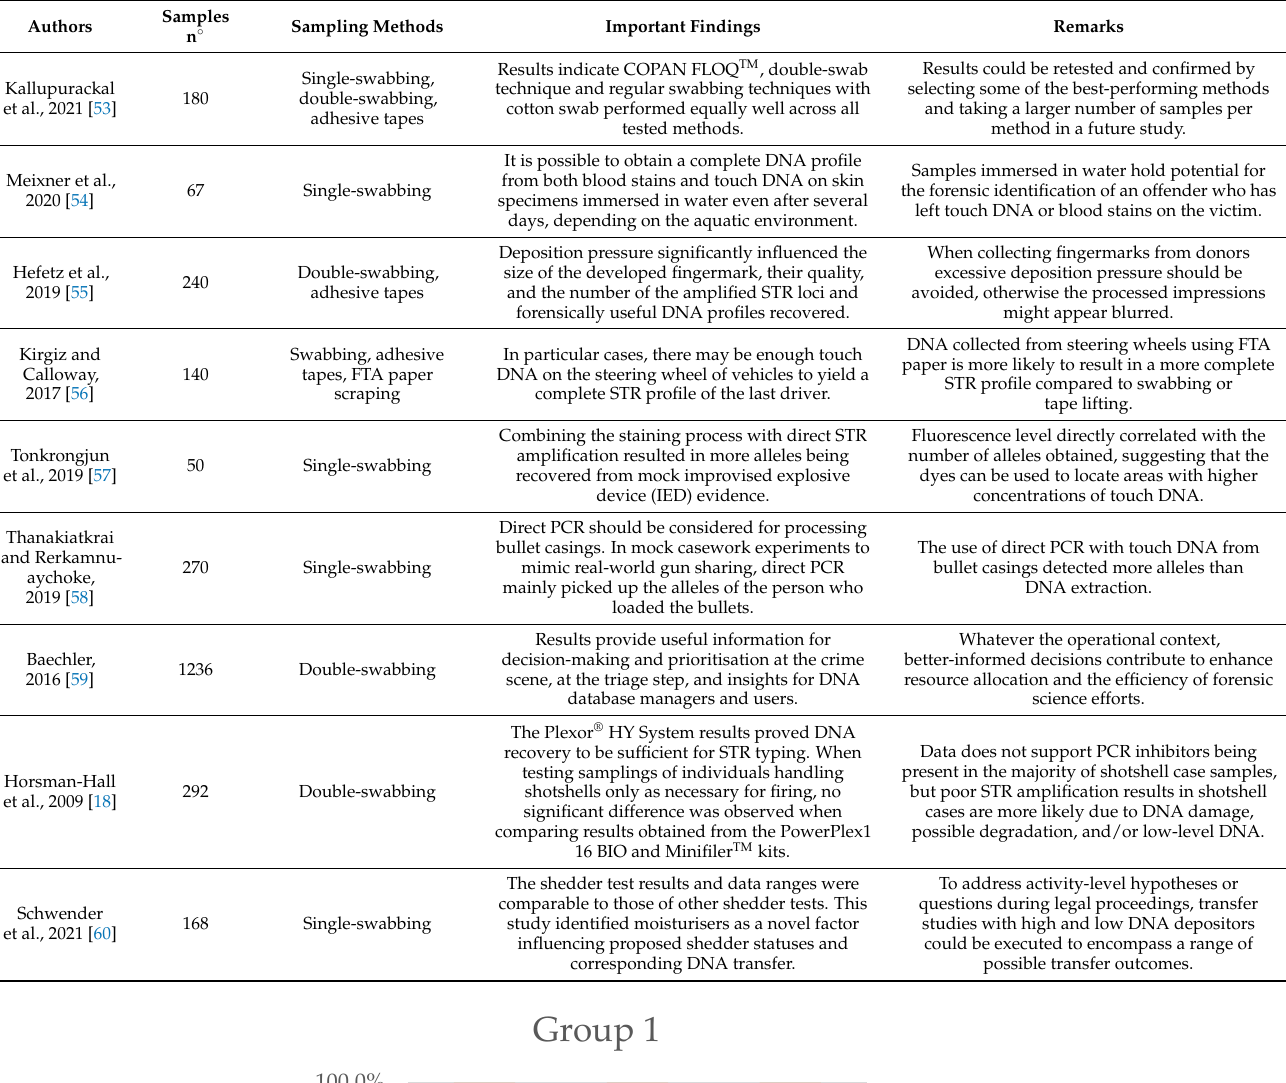
Table 1. Papers categorized in Group 1. Features displayed are authors and publication year, number (n ◦ ) of samples collected, sampling methods implemented, important findings, and remarks highlighted.